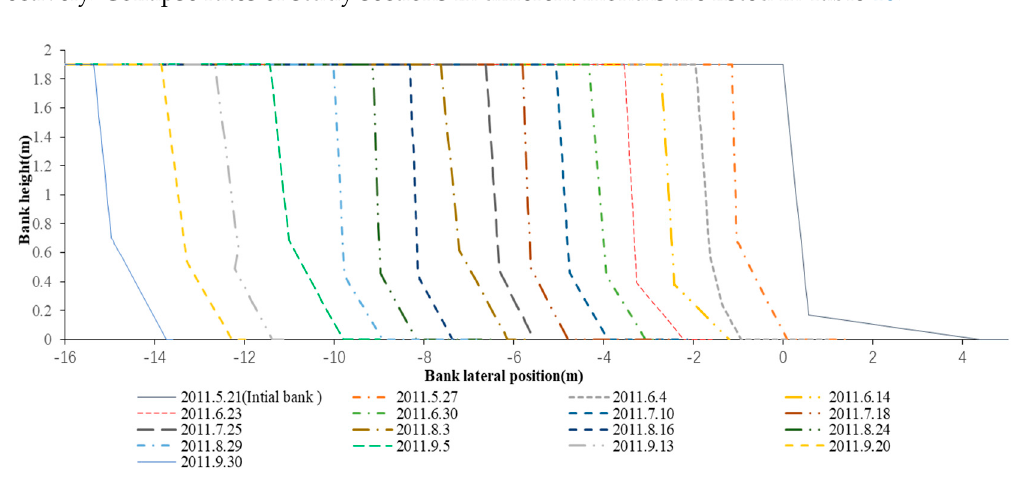
Figure 7. Collapse phases for Section 2.